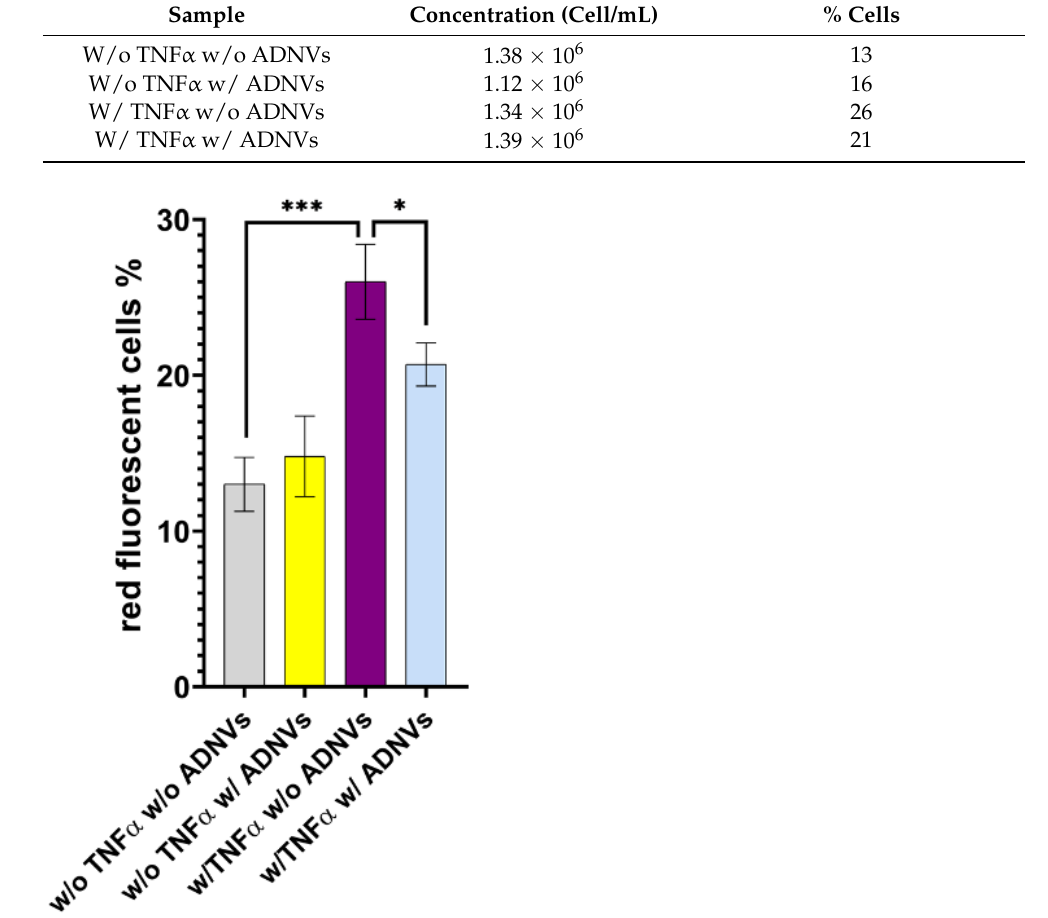
Figure 10. Mitochondrial stress under all conditions is expressed as percentage of cells with above mitochondrial ROS production. * p < 0.05, *** p <